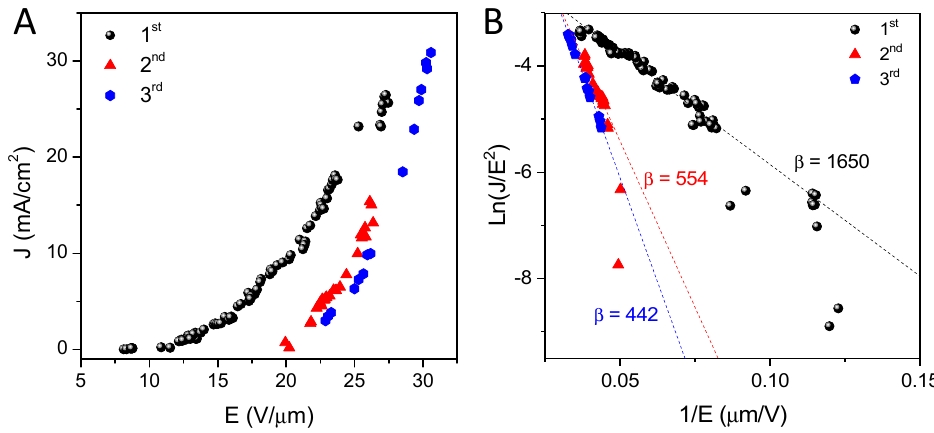
Figure 9. Field emission performance of SWNTs grown on TiN. J-E curves ( A ) and Fowler-Nordheim plots ( B ) of three consecutive field emission measurements on SWNTs samples.